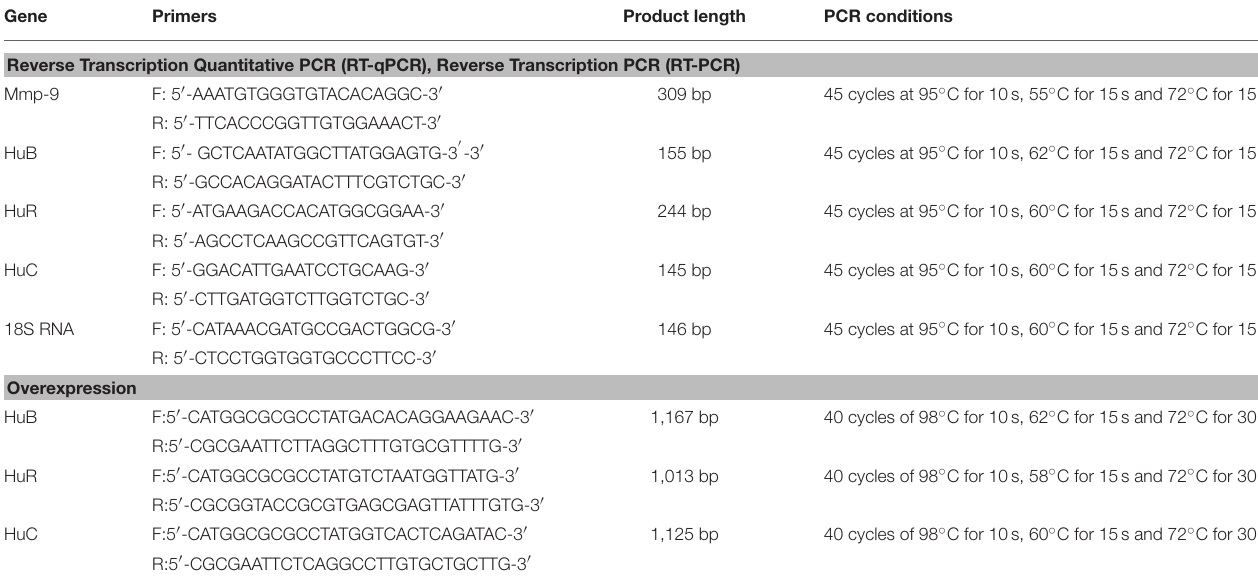
TABLE 1 | Primers and conditions for RT-qPCR and cloning experiments. Gene Primers Product length